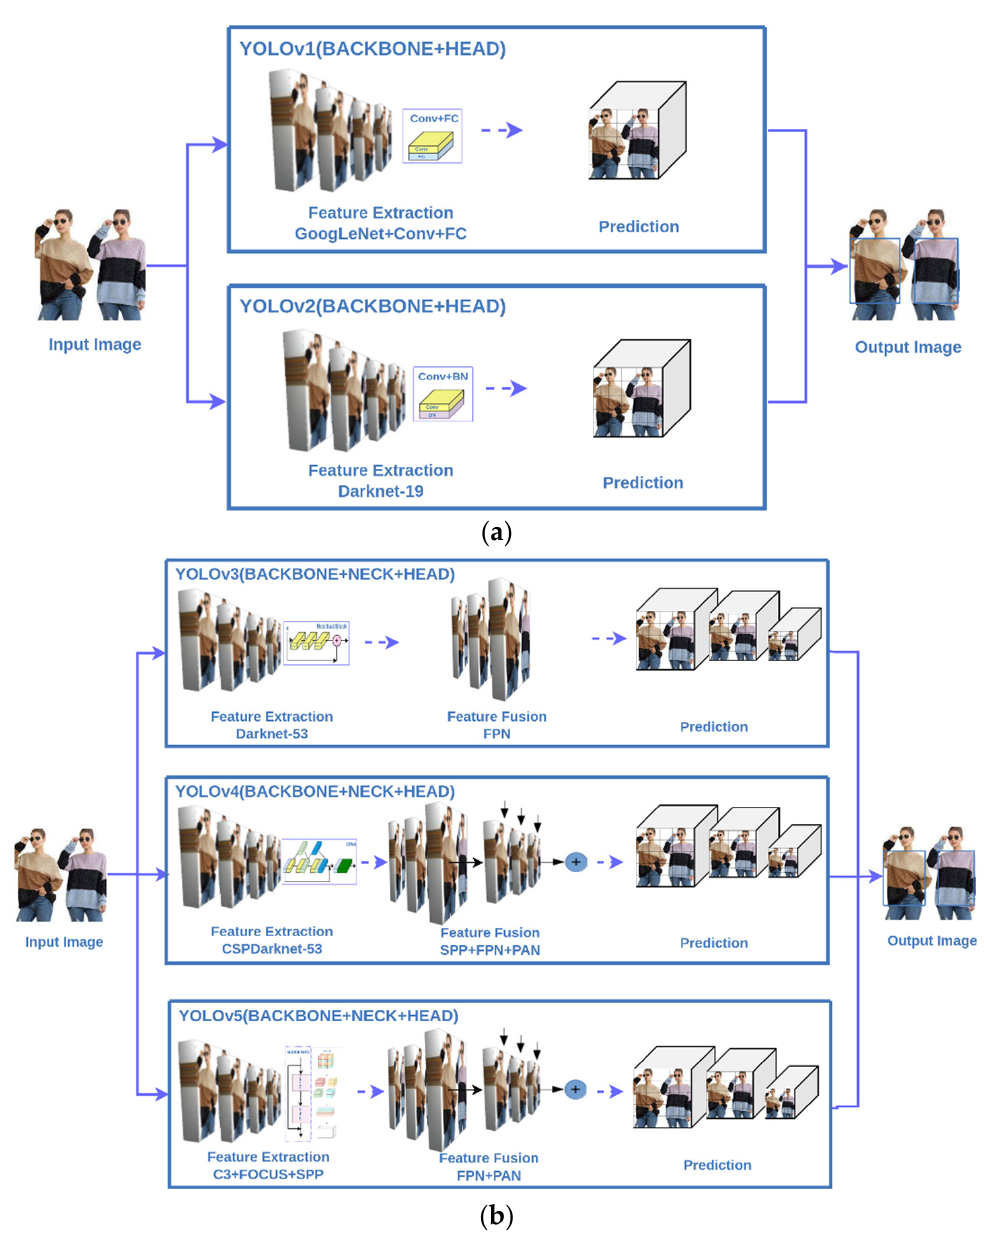
Figure 5. Architecture of YOLO: ( a ) YOLOv1~YOLOv2, ( b ) YOLOv3~YOLOv5.